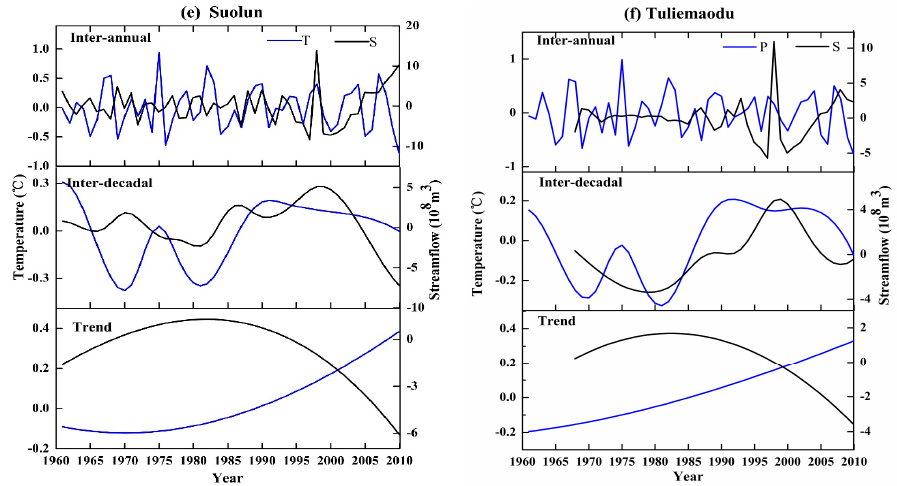
Figure 5. Nonlinear response of streamflow (S) at six gauge stations (( a ) Beian, ( b ) Shihuiyao, ( c ) Xiaoergou, ( d ) Zhalantun, ( e ) Suolun and ( f ) Tuliemaodu) to air temperature (T) during 1961–2010 in the headwater region of the Nenjiang River Basin, Northeast China.